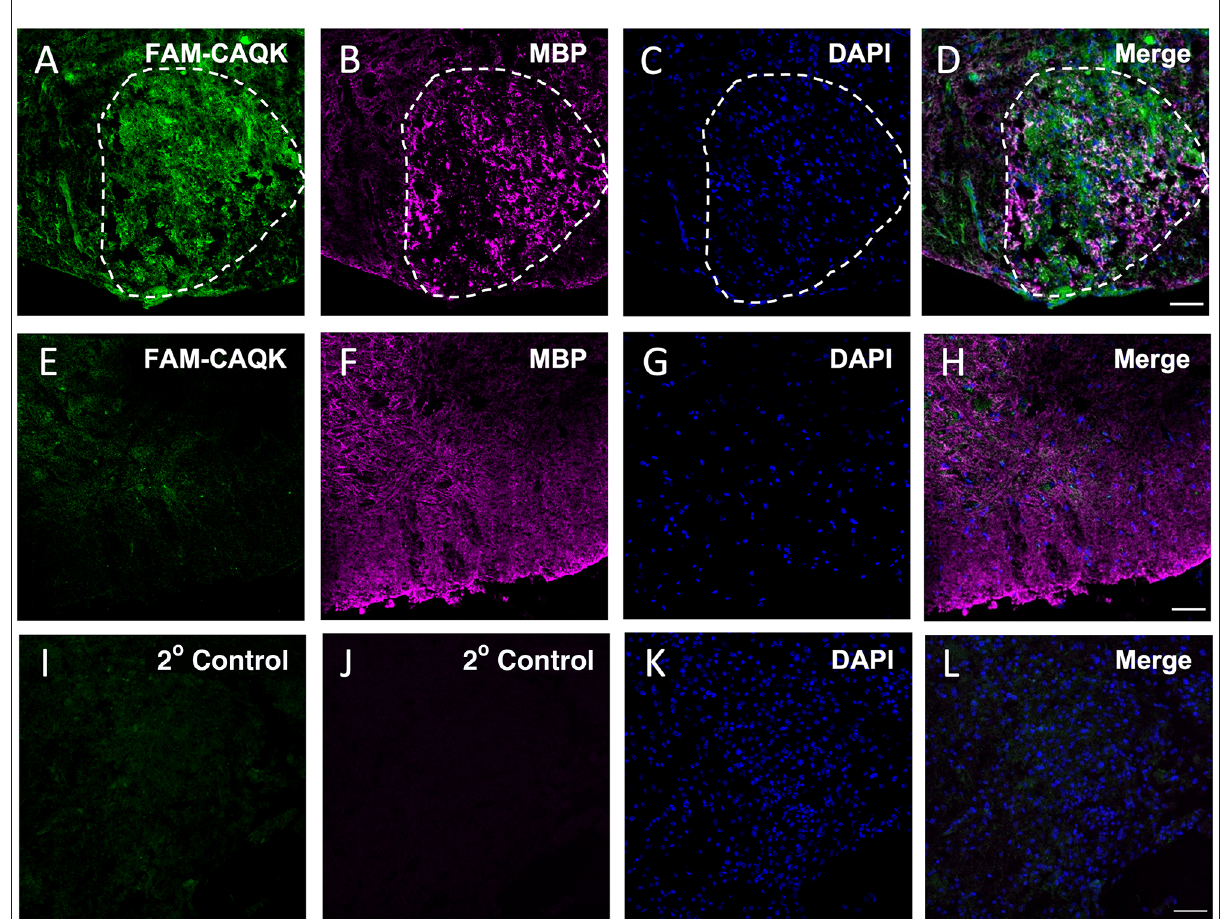
FIGURE1 CAQK homes to lysolecithin-induced focal lesions in the spinal cord. FAM-CAQK (green) accumulates at lesion sites 5 days after LPC injection ( A–D , LPC). The lesion area outlined by white dashes was identified by disorganized MBP staining ( B , magenta) and the increased density of mononucleated DAPI + cells (blue in C,K ) compared to healthy tissue (blue in G ). FAM-CAQK peptide (E) does not accumulate in white matter ( F , MBP, magenta) in sham-operated, PBS-injected spinal cord tissue ( E–H , sham). Panels (I–L) show the corresponding secondary antibody controls around a lesion site in LPC-injected tissue. N = 3–4 mice per group. Scale bar 50 µ